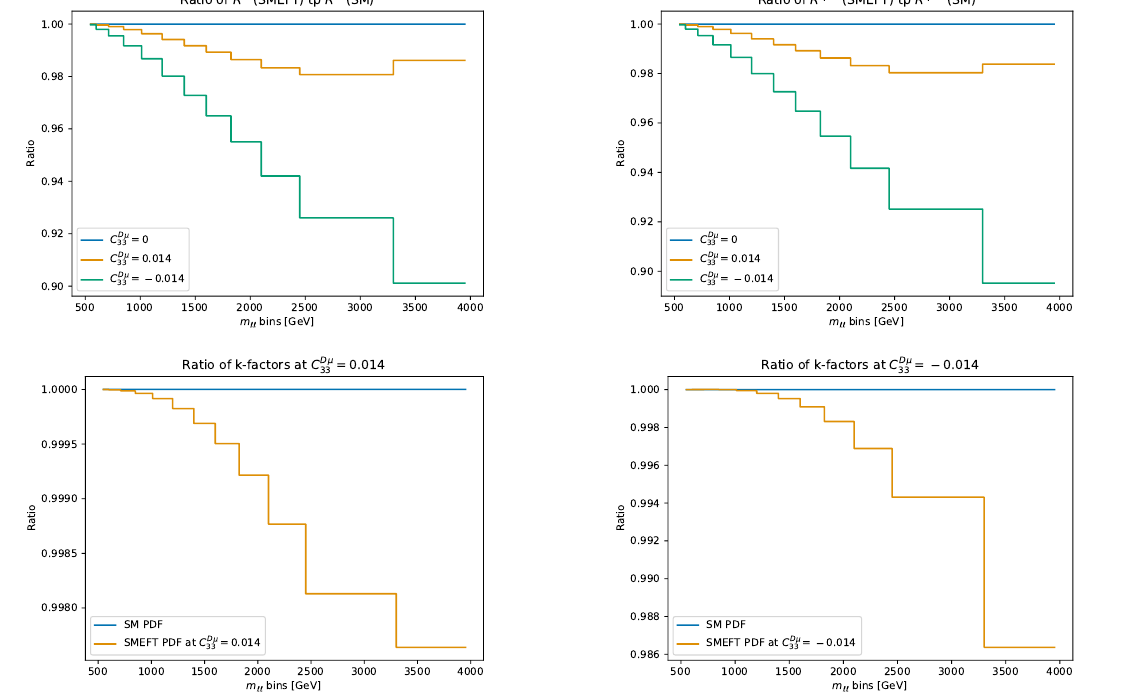
Figure 30 . The impact of the SMEFT PDFs on R lin , R quad (above) and the SMEFT K -factor K = 1 + C Dµ R lin + ( C Dµ ) 2 R quad (below) calculated at the Scenario II benchmark points C Dµ 33 33 ± 0 . 014